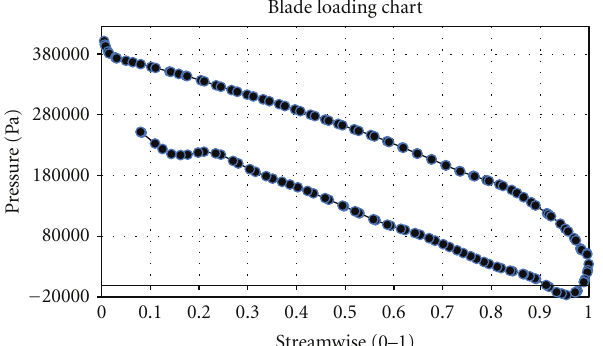
Figure 7: Blade loading in midspan, at 76.14 m 3 /s.